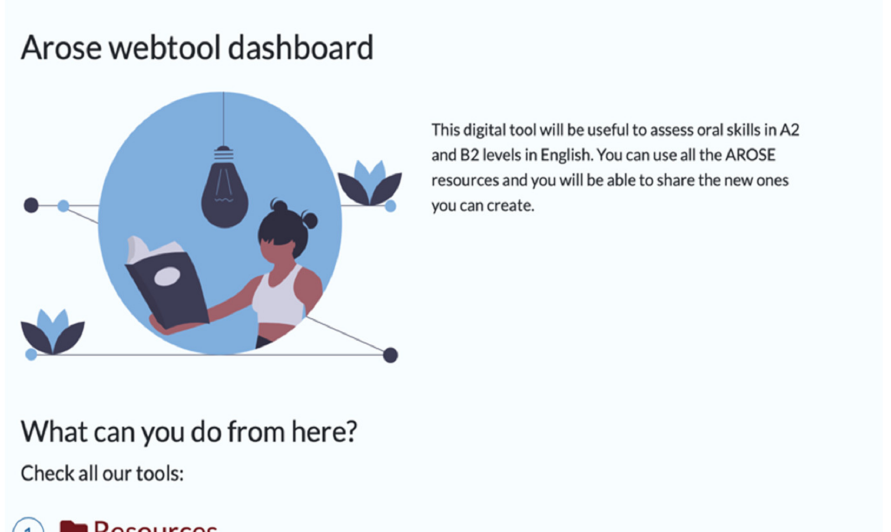
Figure 1. AROSE web tool (https://arose.programaseducativos.es/) (accessed 10 November